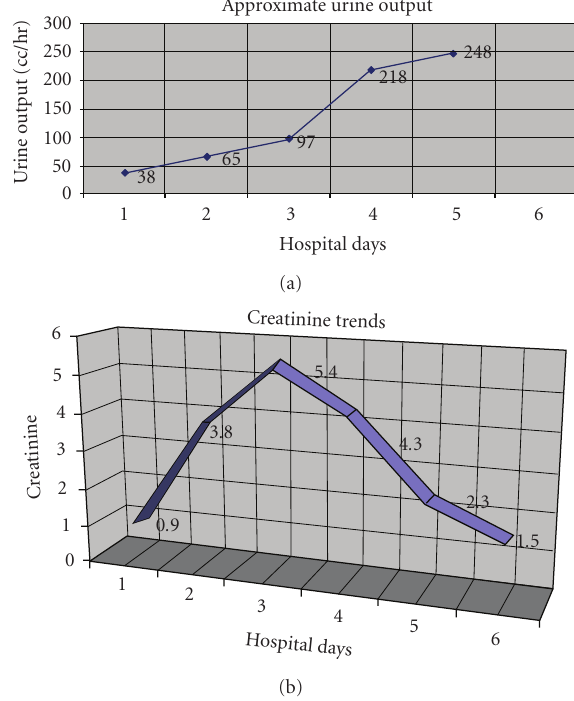
Figure 1: One dose of 800 mg of IV acyclovir was given on Day 1 and then the patient received one dose of 800mg orally that night. On the morning of Day 2, the acute kidney injury was found and acyclovir was stopped immediately. The patient had received 800mg of acyclovir orally five times a day for three days before hospital admission (prior to Day